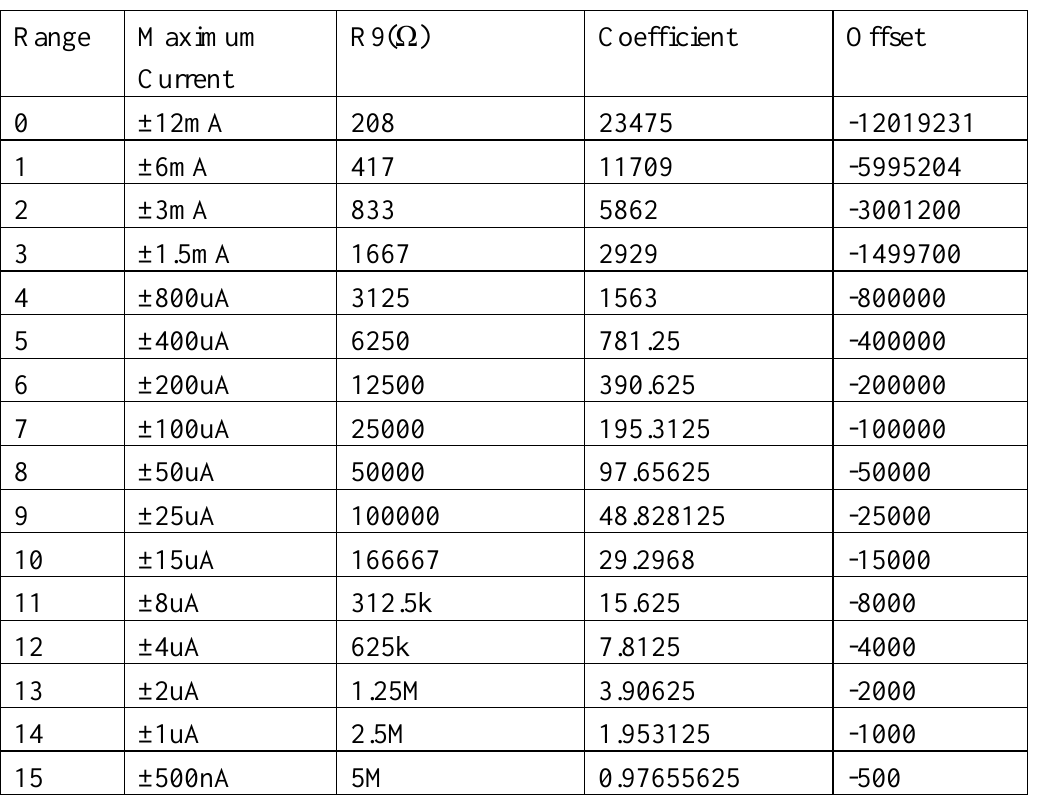
Table 1. The Current Ranges, Resistor Values, coefficients and offsets for the ranges used in the auto- ranging